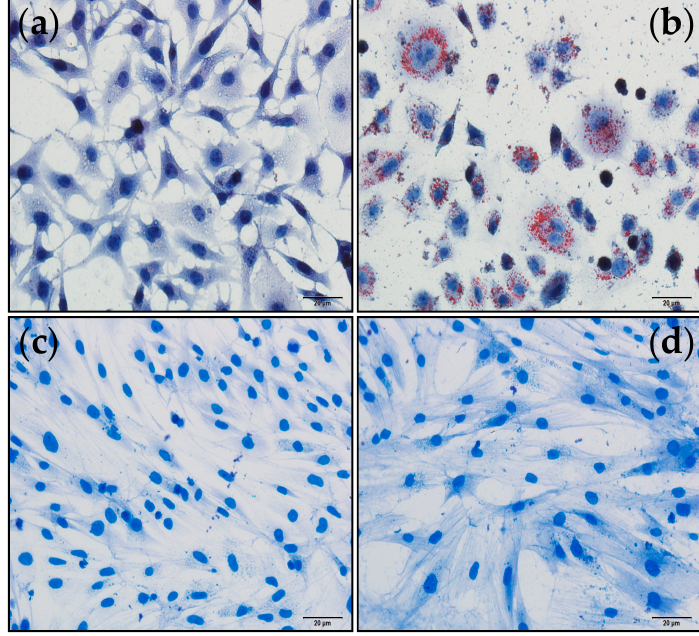
Figure 5. Before and after differentiation of 3T3-L1 and L6 cell lines (Scale bar = 20 μ m): ( a ) before differentiation of 3T3-L1 adipocytes strained with Oil Red O; ( b ) after differentiation of 3T3-L1 adipocytes strained with Oil Red O, the cells under microscope were found to exhibit the phenotype of mature adipocytes with many “ring-like” lipid droplets; ( c ) before differentiation of L6 cell line, strained with Coomassie Brilliant Blue; and ( d ) after differentiation of L6 cell line strained with Coomassie Brilliant Blue, to exhibit myotube-like structure.